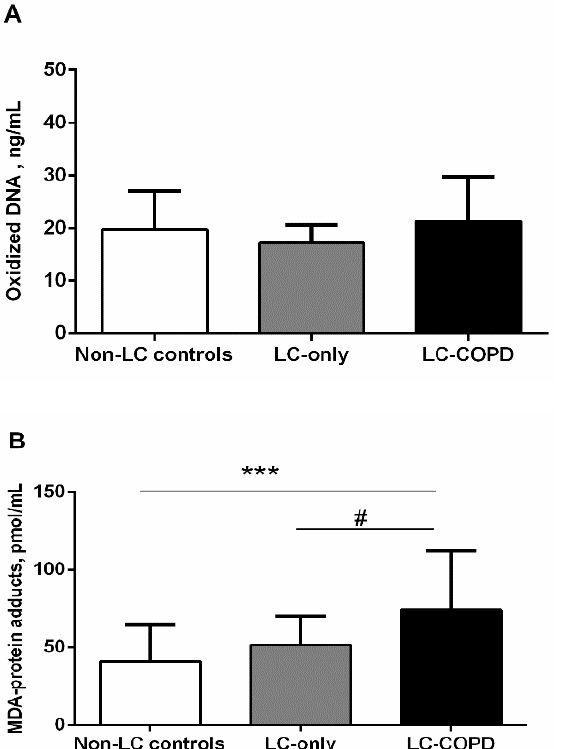
Figure 3. ( A ) Mean values and standard deviation of levels of oxidized DNA (ng/mL) did not differ between the study groups of subjects. ( B ) Mean values and standard deviation of level of MDA-protein adducts (pmol/mL) were significantly higher in LC-COPD patients compared to non-LC control subjects and LC-only patients. Statistical significance is as follows: *** p < 0.001 between LC-COPD patients and the non-LC control subjects, # p < 0.05 between LC-COPD patients and LC-only patients. The absence of statistical symbols indicates that no significant differences were found between groups for the different study comparisons.